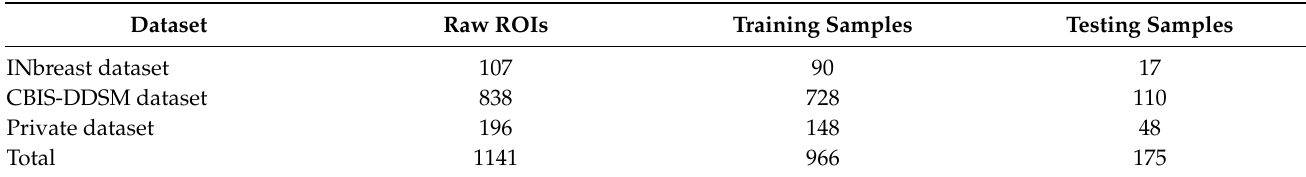
Table 1. Distribution of the mammography datasets.